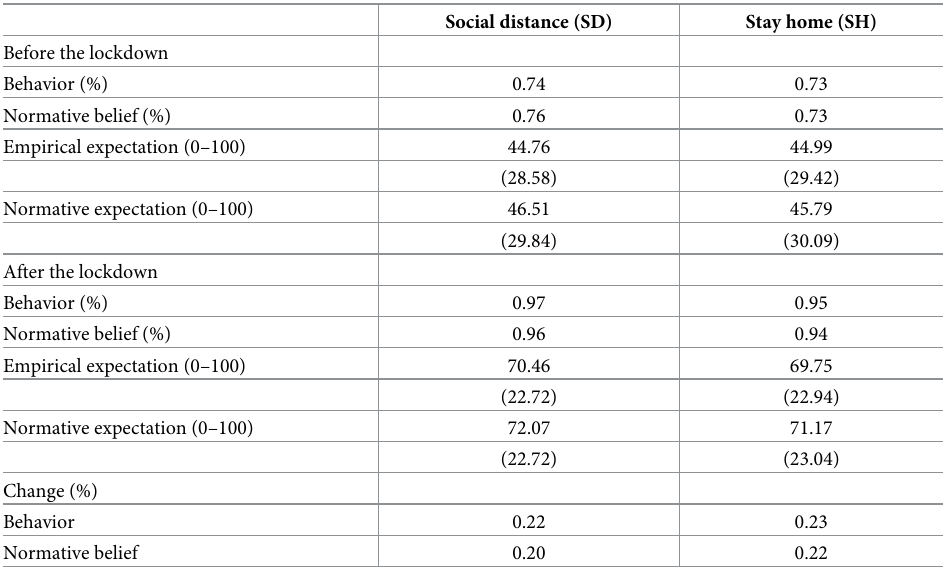
Table 1. Behavior, normative beliefs and